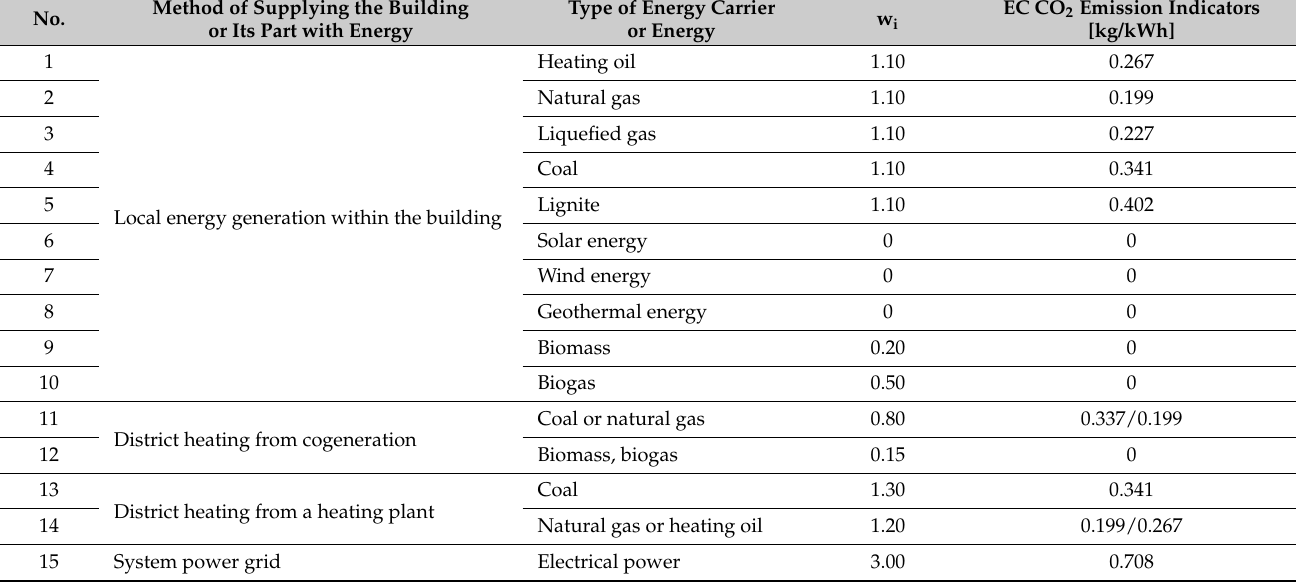
Table 2. Coefficients of non-renewable primary energy input w i [28] and EC CO 2 emission indicators applicable in